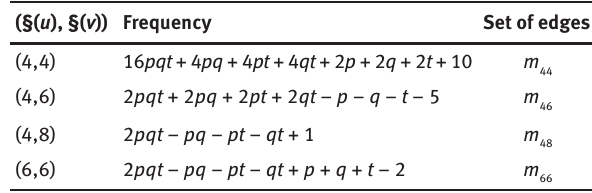
[ p , q , t ] based on degree of 2